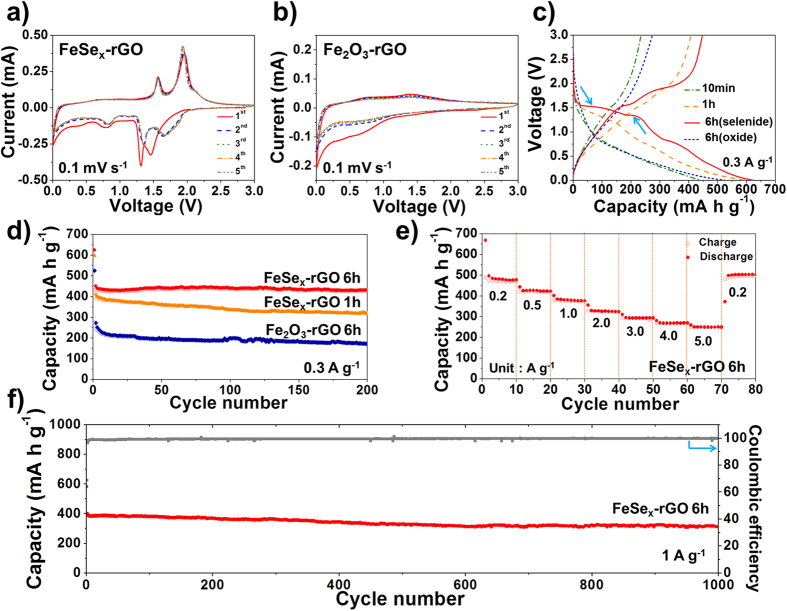
Electrochemical properties of the hollow FeSex- and Fe2O3-decoreated rGO composite powders: (a) CV curves of FeSex-rGO, (b) CV curves of Fe2O3-rGO, (c) initial charge-discharge curves, (d) cycling performances, (e) rate performance, and (f) long term cycling performance.